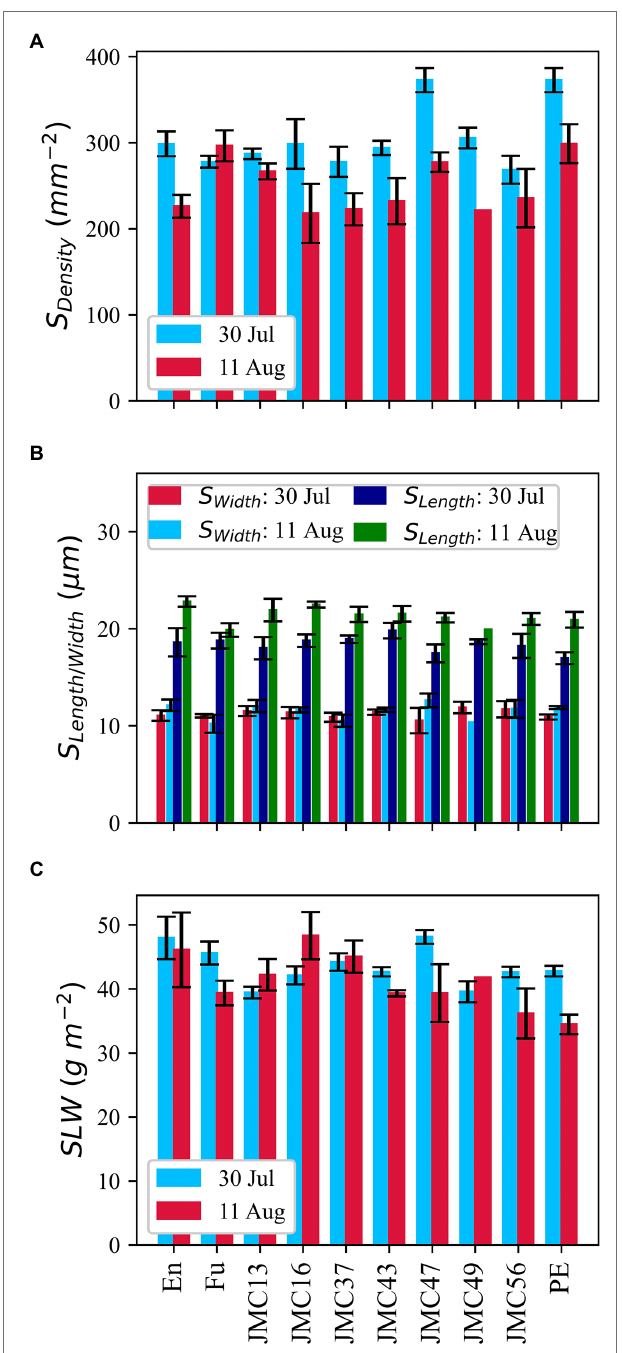
FIGURE 7 | Phenotypic variations in morphological parameters of stomatal density (A) , the length and width of stomata (B) , and specific leaf weight (C) . Data point is the mean of four observations. Error bars indicate standard